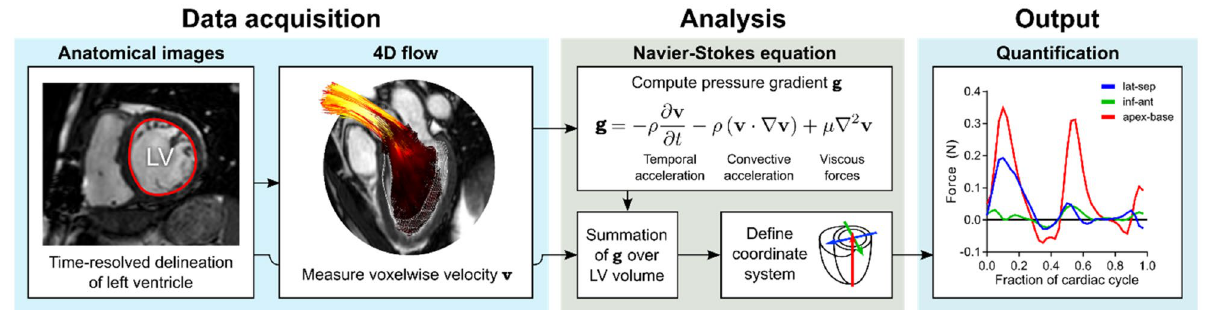
Figure 1. Method overview. LV segmentation is performed in standard short-axis bSSFP images and used as boundaries for the 4D flow data. The flow field is then used as input to the Navier–Stokes equation to compute the instantaneous pressure gradient, which is subsequently integrated over the LV to produce the global hemodynamic force vector. This vector can then be decomposed into three orthogonal